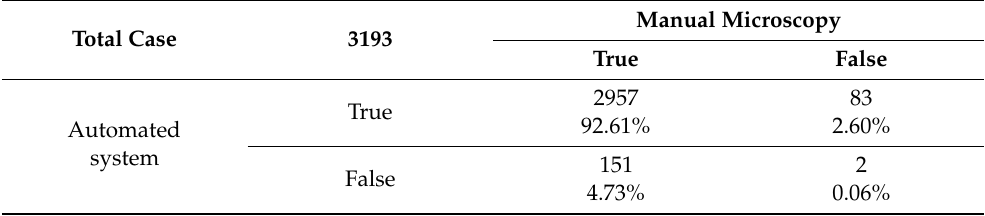
Table 6. The precision and error rate of the automation system and manual microscopy. The “True” represents the cases diagnosed correctly; the “False” represents the cases of wrong diagnosis, after removal of inadequate